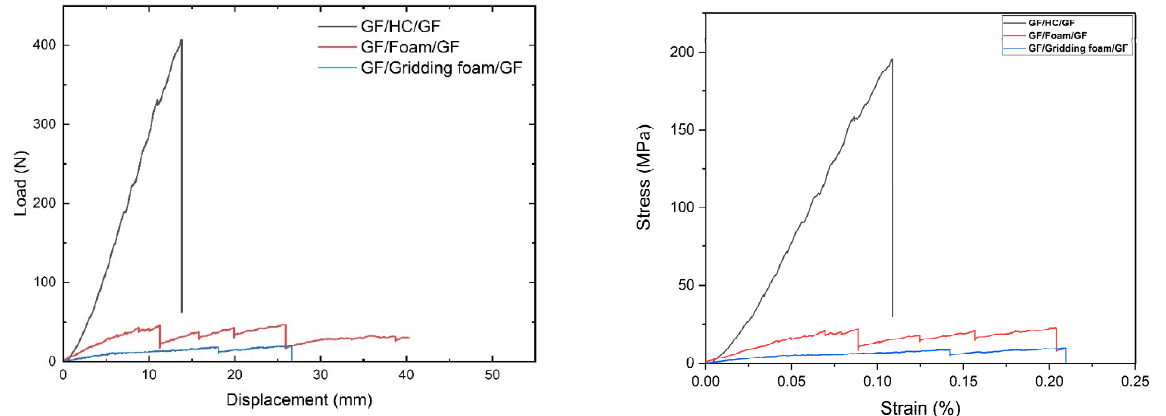
Figure 7. Pictures of the three ‐ point bending test performed to: ( a ) GF/HC/GF, ( b ) GF/Foam/GF, ( c ) GF/Gridding foam/GF. The pictures present the damages that occurred during the test.